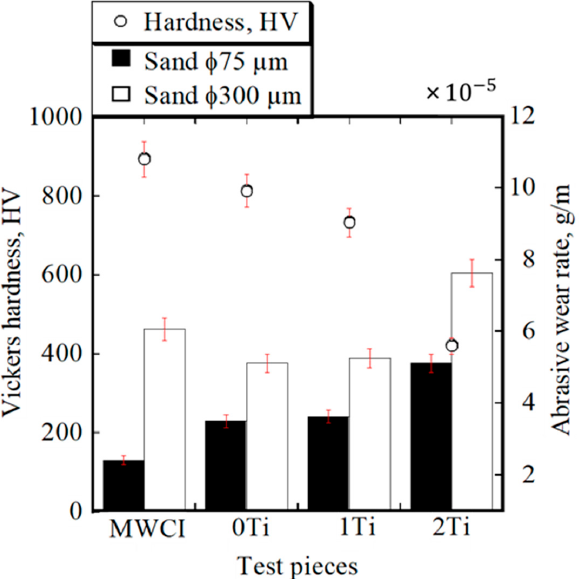
Figure 9. The relationship between Vickers hardness and abrasive wear rate of the